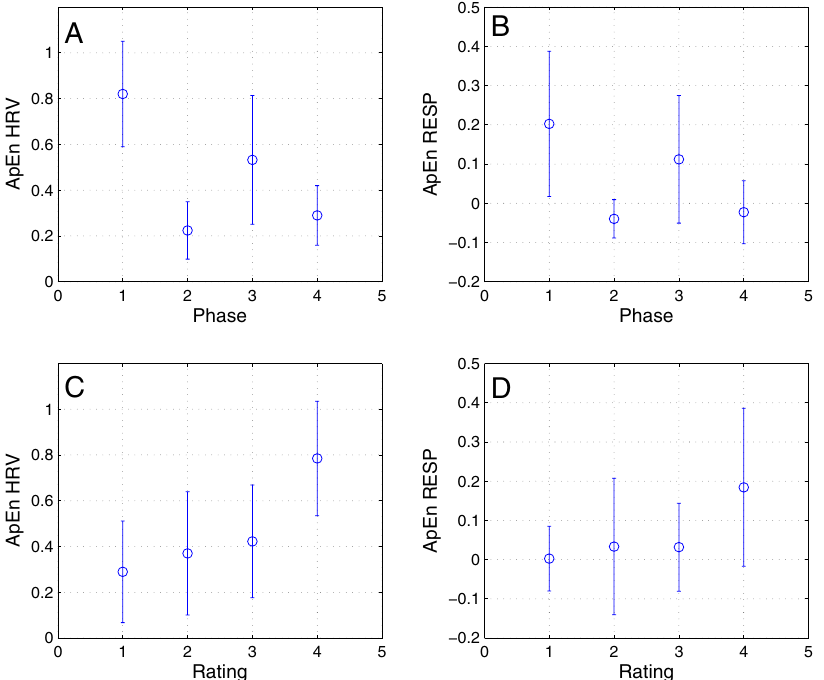
Figure 5. Means and standard deviations of approximate entropies of heart rate variability and breath frequency plotted against flight phase (1–before engine failure, 2–engine failure, 3–glide, 4–approach and landing) and subjective rating (1–most perceived stress, 4–least perceived